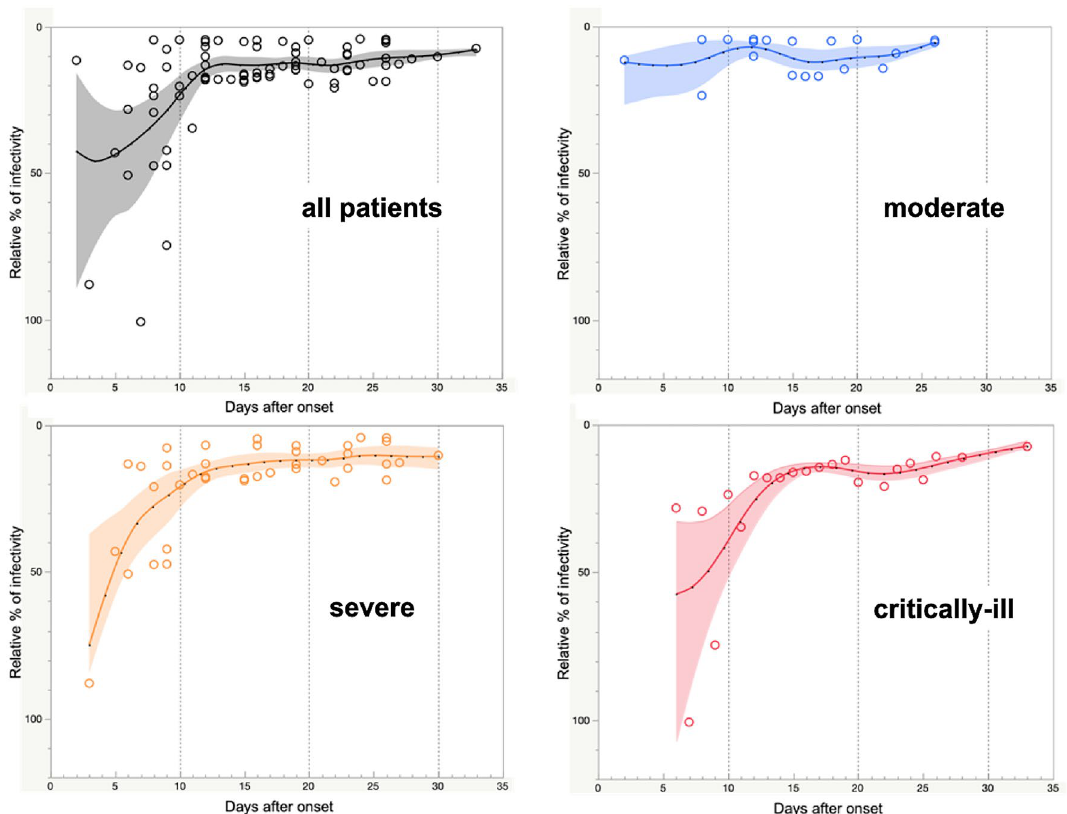
Figure 1. Trends in neutralization activities in symptomatic patients stratified by severity. Nonlinear regression models of all eleven patients (black), four moderate (blue), six severe (orange), and one critically ill patients (red). The models were calculated using the mean data of three independent assays of the patients stratified by severity. Solid curves are spline curves fitted to the mean with a λ of 0.05. Shading indicates the 95% confidence interval of each